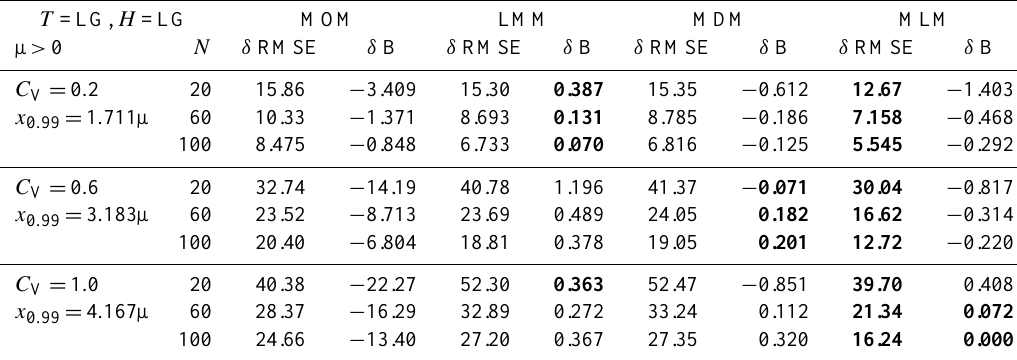
Table 4. Relative accuracy [ % ] of ˆ x 0 . 99 for a sample from LG, assuming LG model.